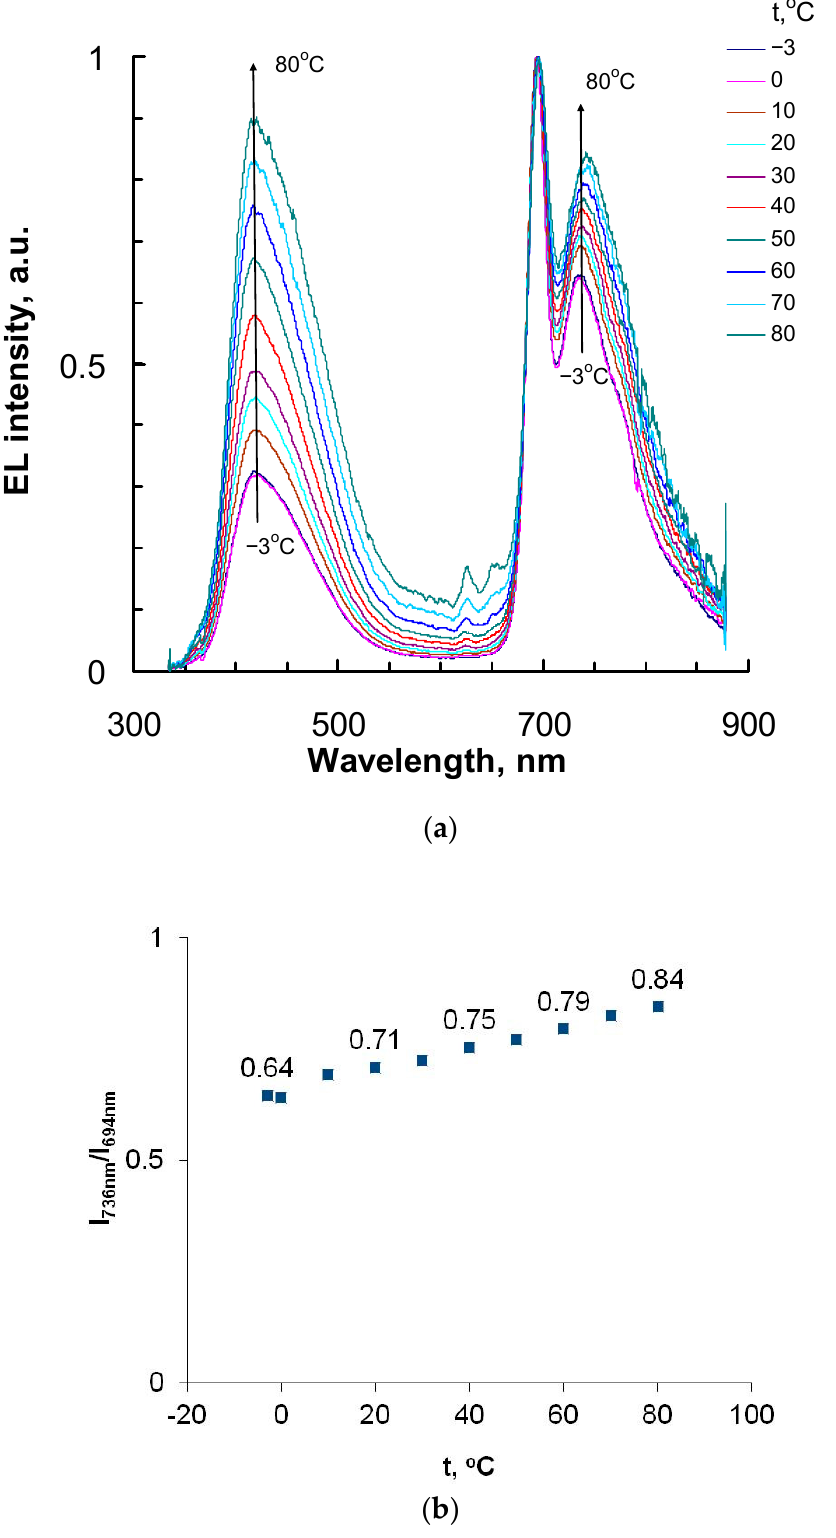
Figure 5. ( a ) Normalized EL spectra of OLED with Cu-EtioP content of 1 wt% in the light-emitting layer at temperatures from − 3 °C to 80 °C at an applied voltage of 10 V. ( b ) Temperature dependence of the EL intensity ratio ( I 736nm /I 694nm ) at band maxima 736 and 694 nm.